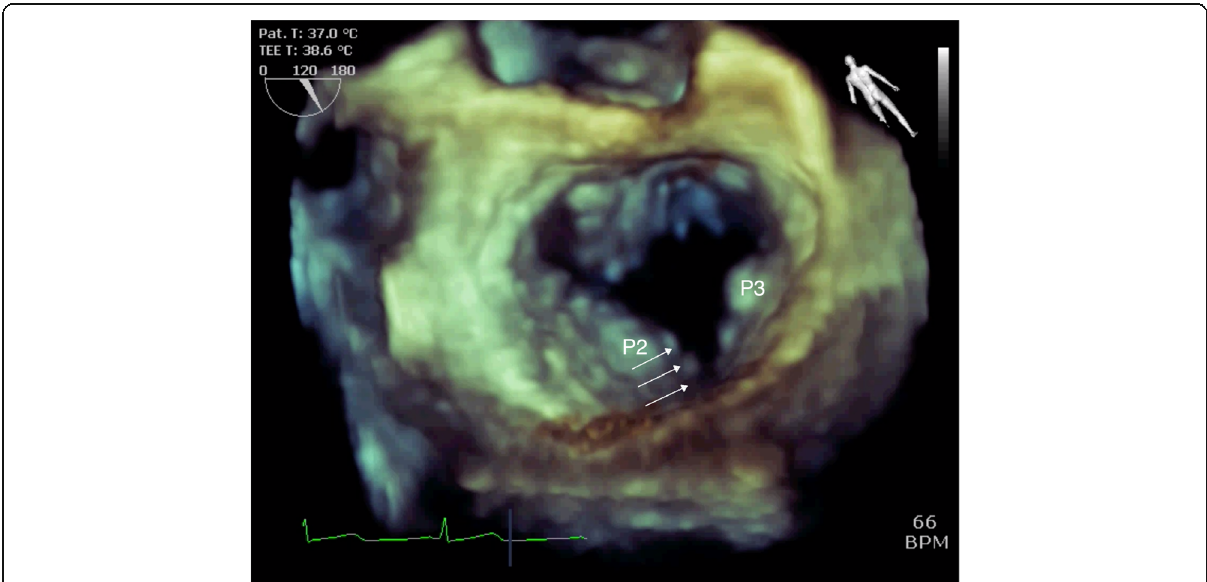
Fig. 4 Three-dimensional echocardiography at the en face view at early diastole showing a profound indentation (cleft) between P2 and P3 (white